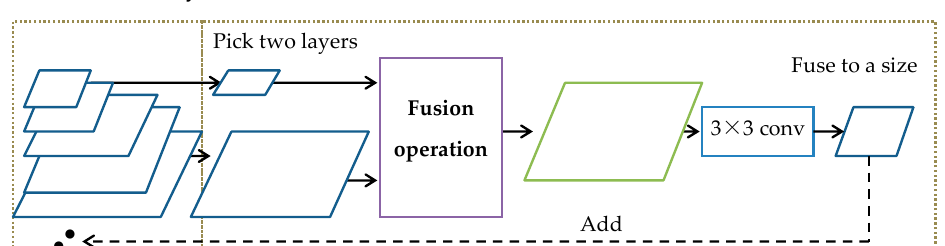
Figure 8. NAS FPN fusion process.